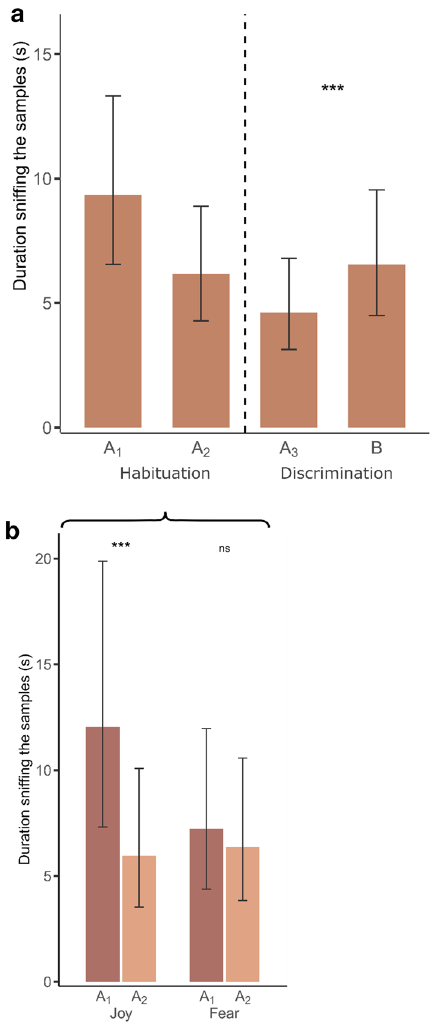
Figure 4. Habituation and discrimination to the samples. ( a ) Habituation and discrimination of all horses. ( b ) Habituation according to the type of odor (e.g., group). The graphs are extracted from the corresponding models presented in Table 2. The error bars represent the standard errors from the models. *** p ≤ 0.001, ns: p >